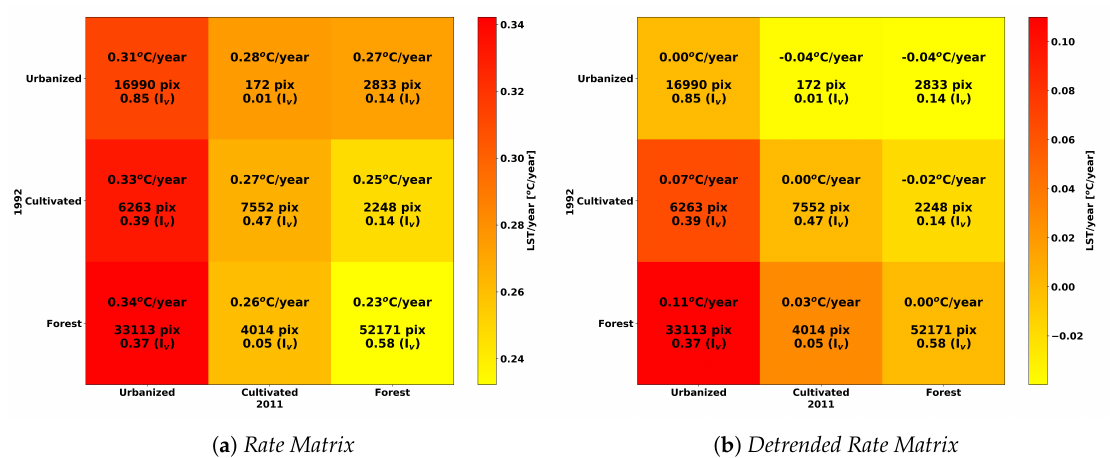
Figure 11. Atlanta MA cold period: Rate and Detrended Rate Matrices